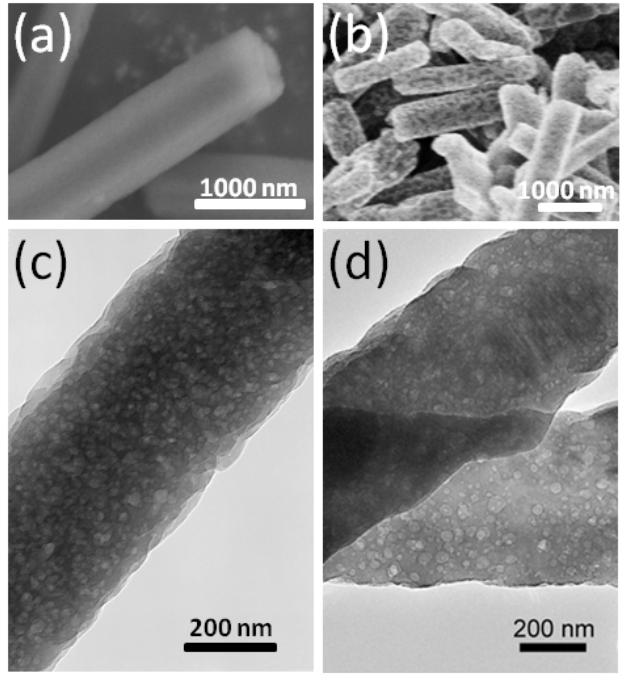
Figure 1. SEM micrographs of ( a ) C micrographs of ( a ) and ( b ) observed using a transmission electron microscope (TEM),